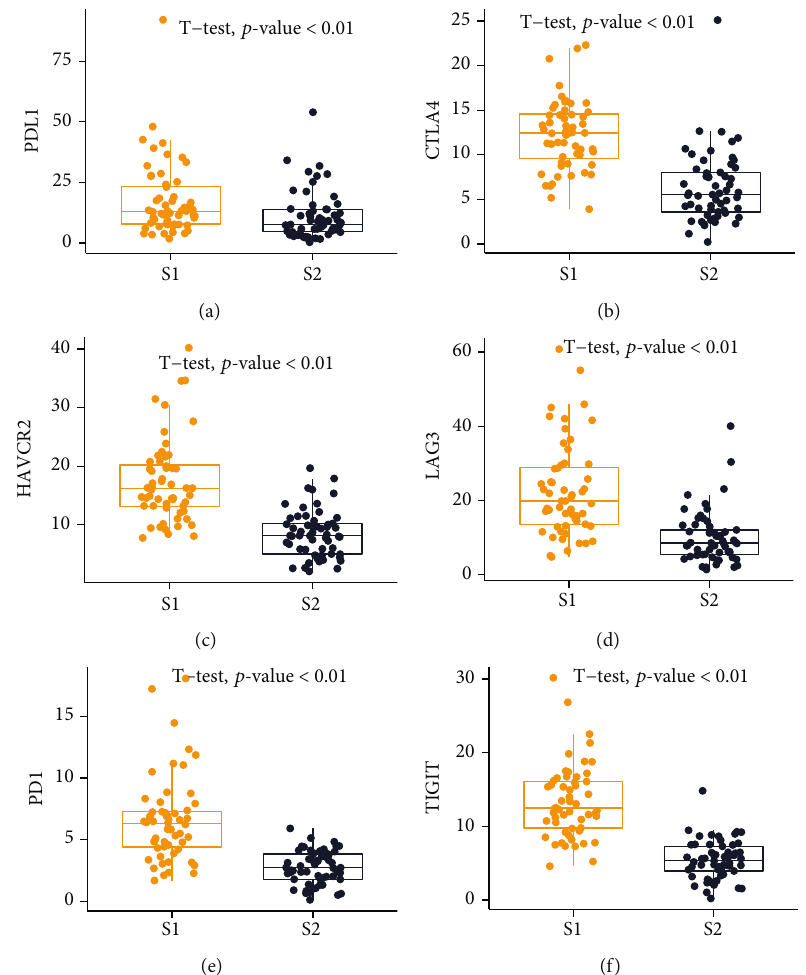
Figure 4: Di ff erential expression of the immune checkpoint genes PDL1, CTLA4, HAVCR2, LAG3, PD1, and TIGIT among two NPC subtypes, as evaluated by t